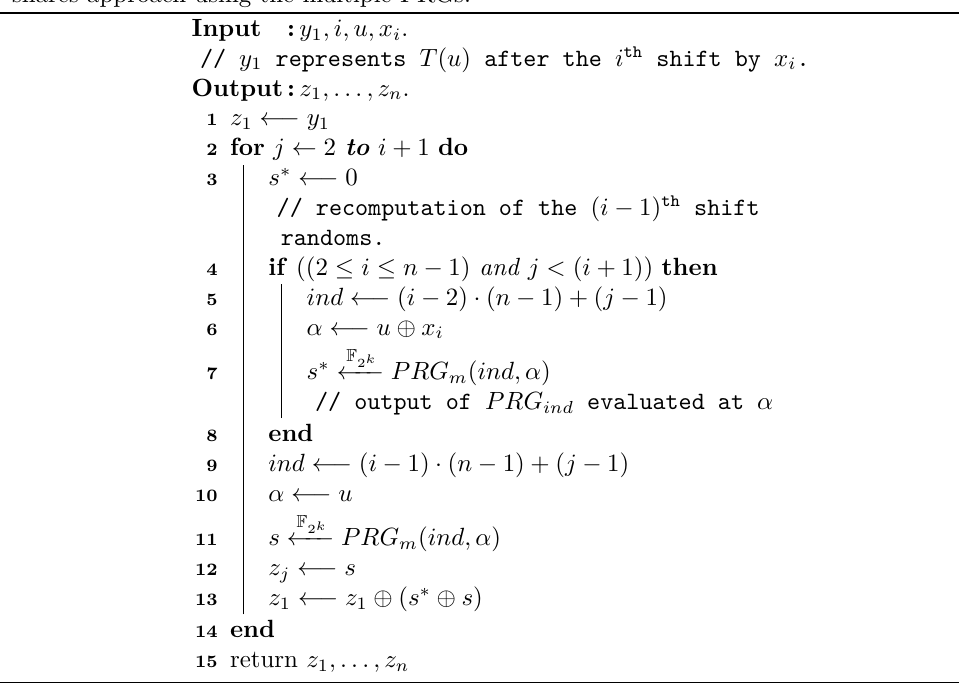
Algorithm 8: LR-i-m : LR procedure for the increasing shares approach using the multiple PRGs.